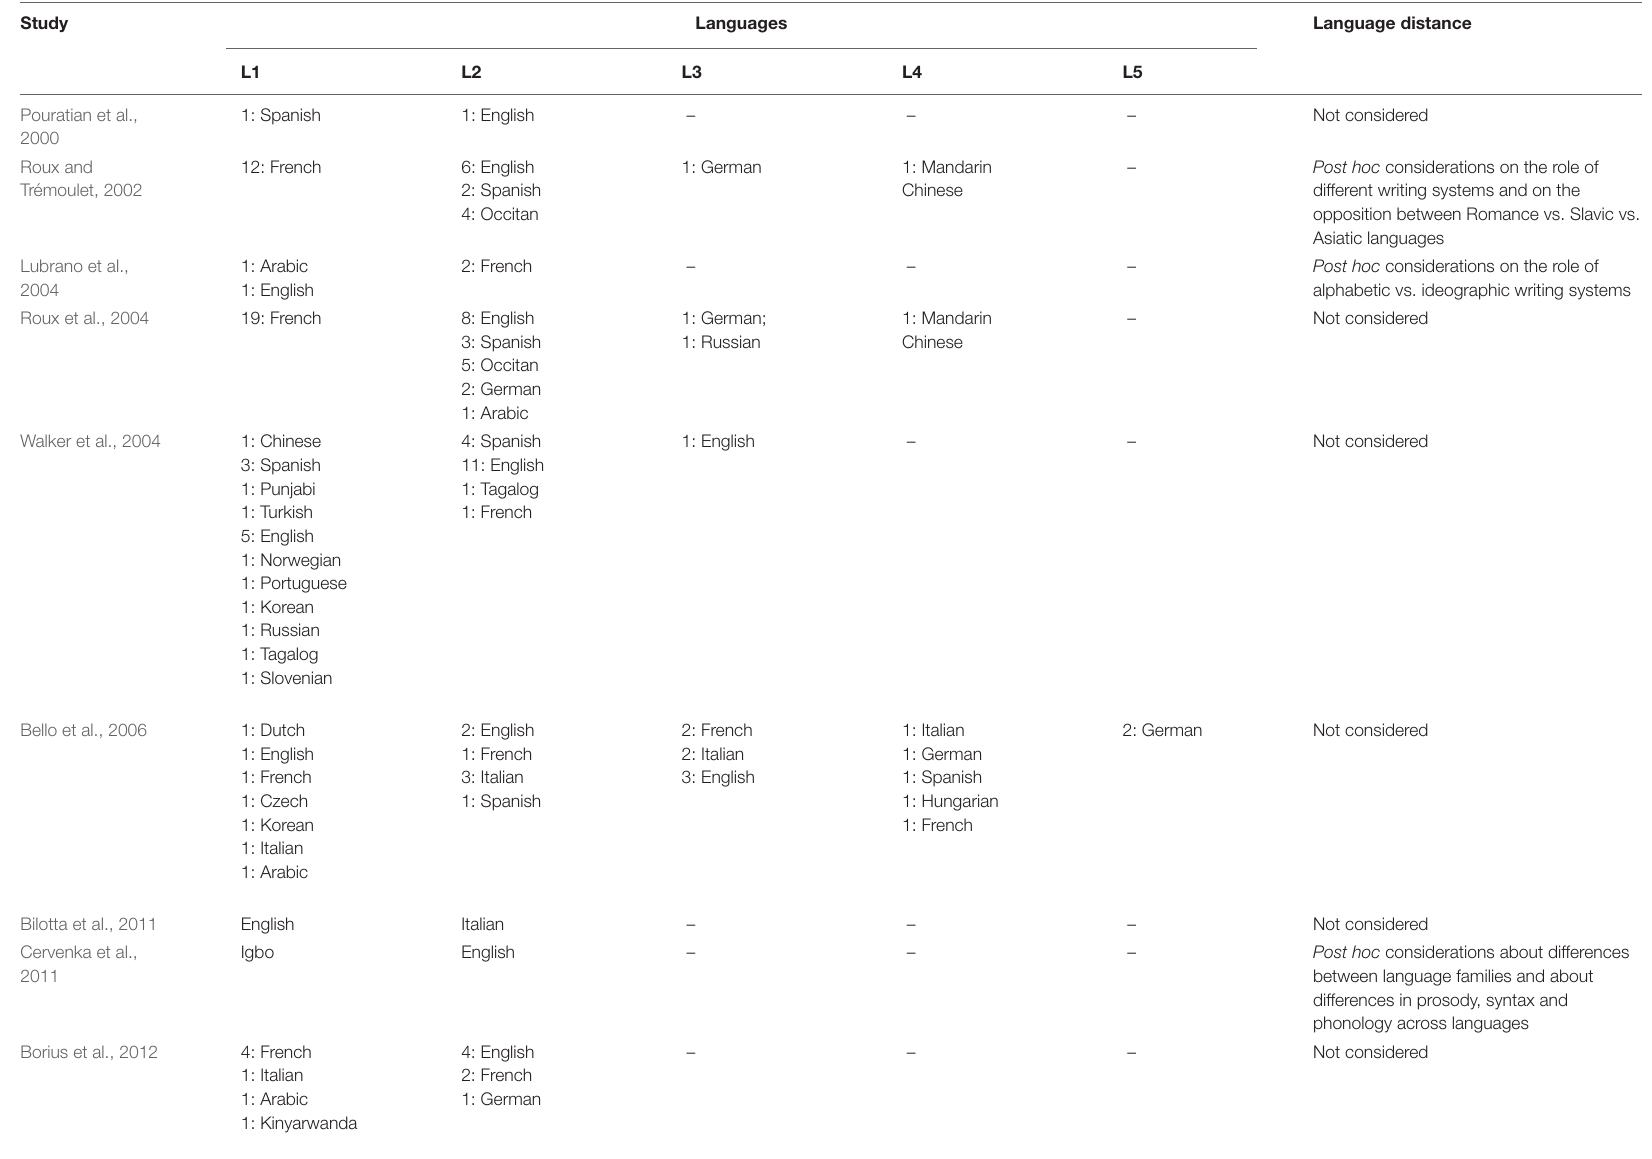
TABLE 2 | Number and types of studied languages and language distance/similarity.